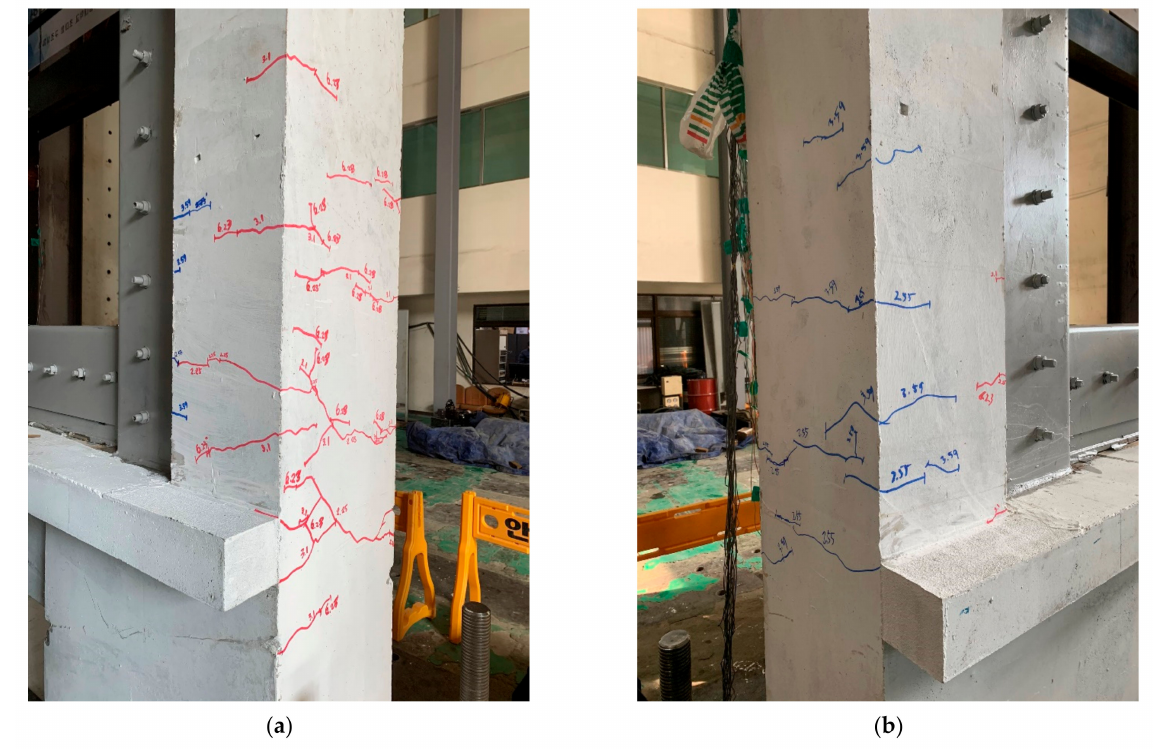
Figure 11. Cracks and ultimate state of test frame retrofitted with CFT-MF system (PD-CFT) (200 cm/s 2 ): ( a ) flexural cracks at around 2.25 s and ( b ) flexural cracks at around 3.1 s.